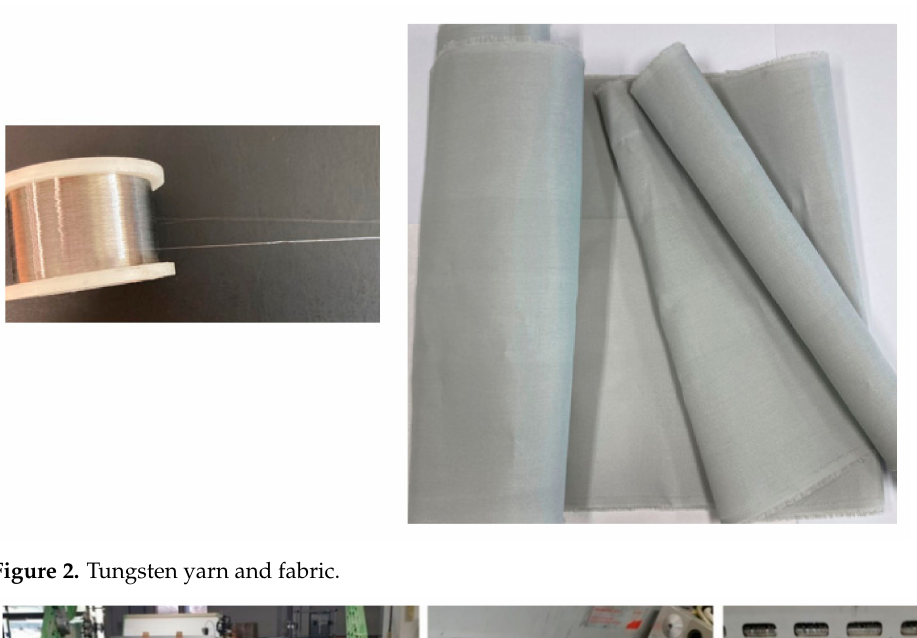
Figure 1. Fabric weaving methods. ( a ) Plain weave method, ( b ) Twill weave method.